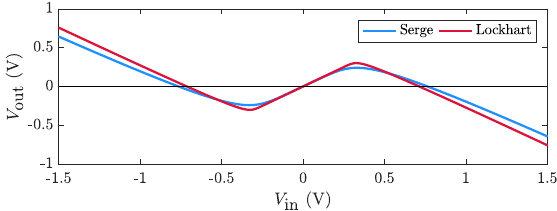
Figure 9. Transfer functions for the proposed Serge and Lockhart ( R L = 7.5k Ω ) wavefolder